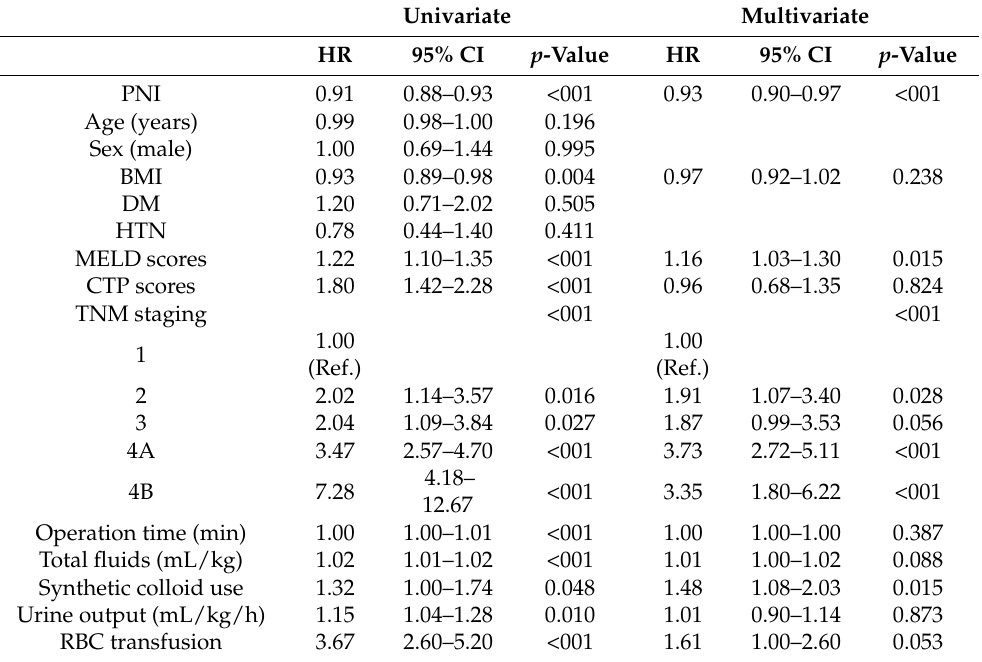
Table 4. Cox regression analyses of five-year